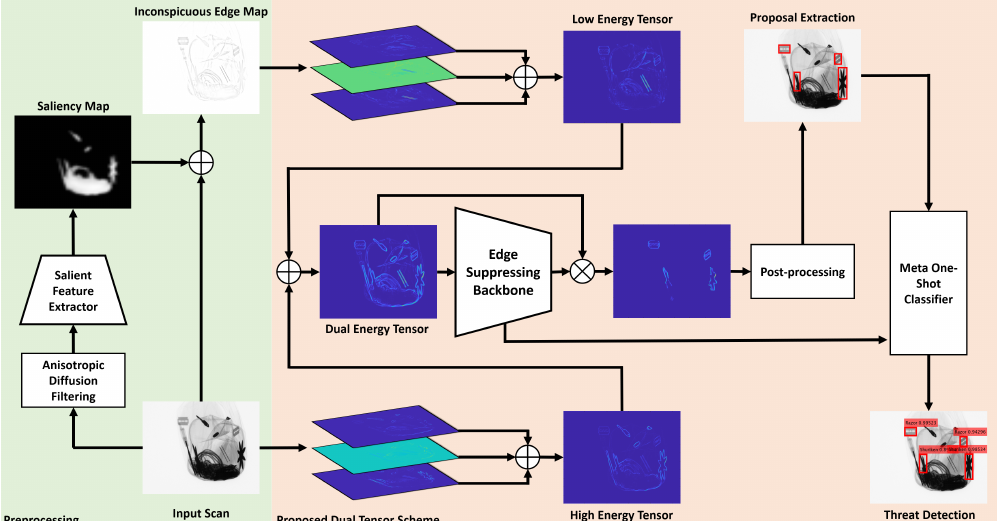
Figure 2. Block diagram of the proposed tensor-shot detector. First of all, we decompose the input scan into high and low energy tensors, where the high tensors are generated directly from the input scan (through the structure tensors [56]). Moreover, the low energy tensors are produced by first computing the salient image features (through the proposed feature extractor) and then accumulating them with the input scan. Both high and low energy tensors are then added together to produce a dual-energy tensor representation of the input scan that is then passed to the edge suppressing backbone to suppress the irrelevant baggage contours while simultaneously highlighting the threatening content. Then, the resultant baggage content is postprocessed, and for each extracted object, a bounding box is fitted to craft out its proposal that is passed to the meta-one-shot classifier for recognizing the object